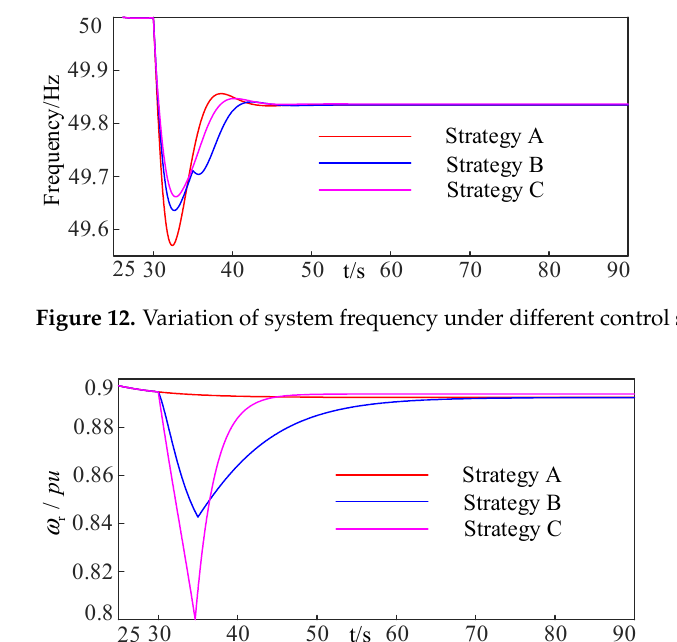
Figure 11. Output power of wind farm and VSC-HVDC under different control strategies. When wind speed is 8 m/s, at t = 30, load L1 suddenly increases 132.25 MW. Three strategies are adopted to validate the proposed method. System frequency and rotor speed are shown in Figures 12 and 13.